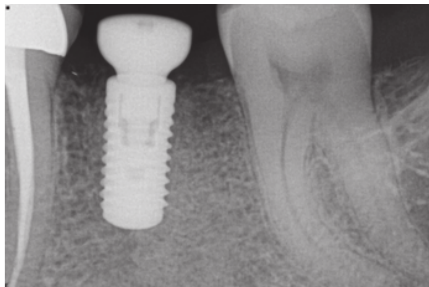
Figure 14: Tooth #18 presented with a hopeless prognosis.